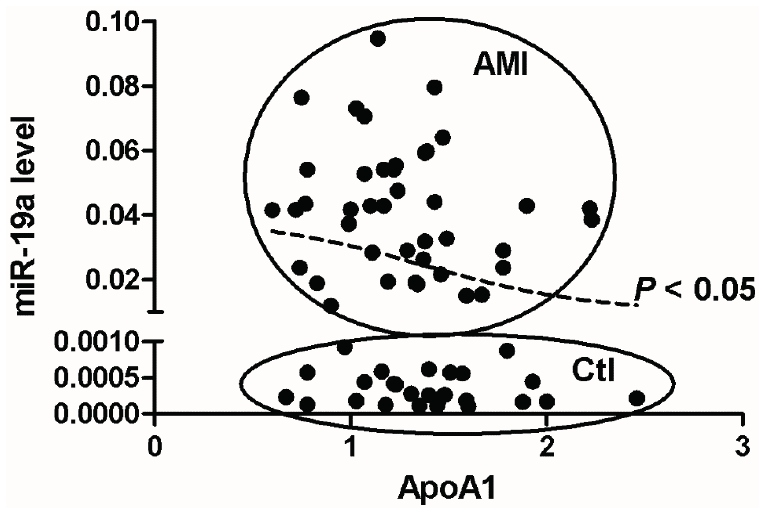
Figure 2. Correlation of miR-19a with the